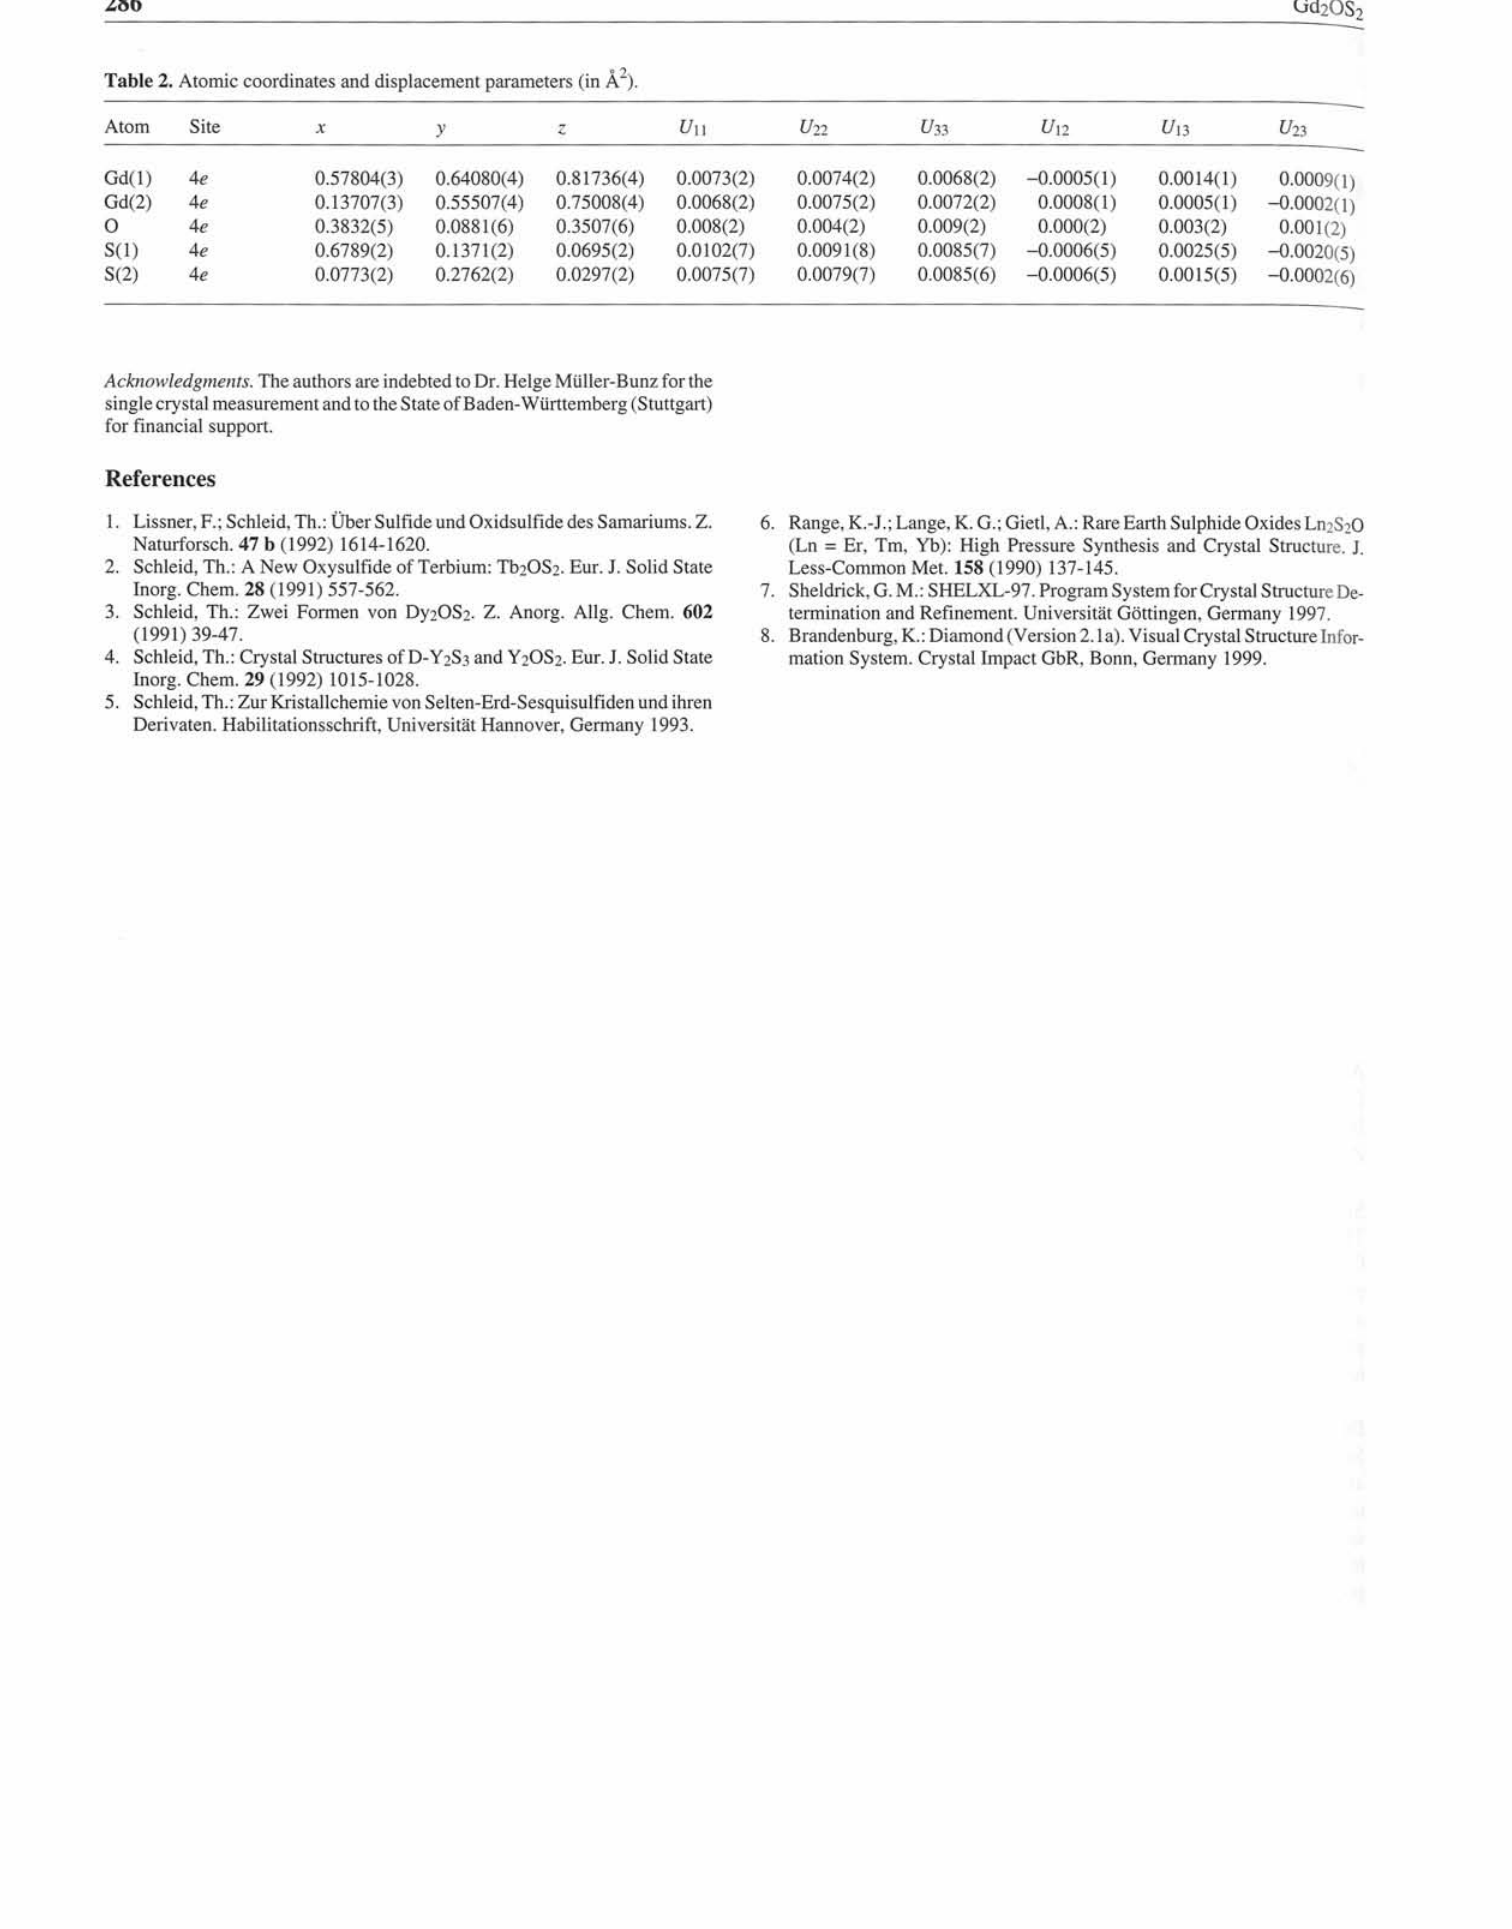
Table 2. Atomic coordinates and displacement parameters